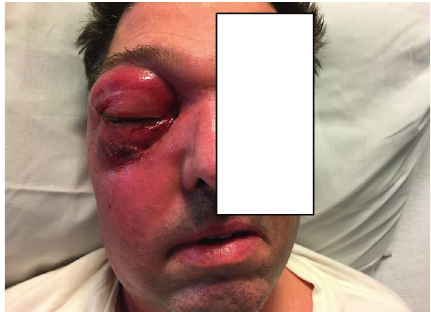
Figure 2: Exuberant periorbital edema, erythema, and superficial excoriation with serous drainage were noted over the right eye and right paranasal